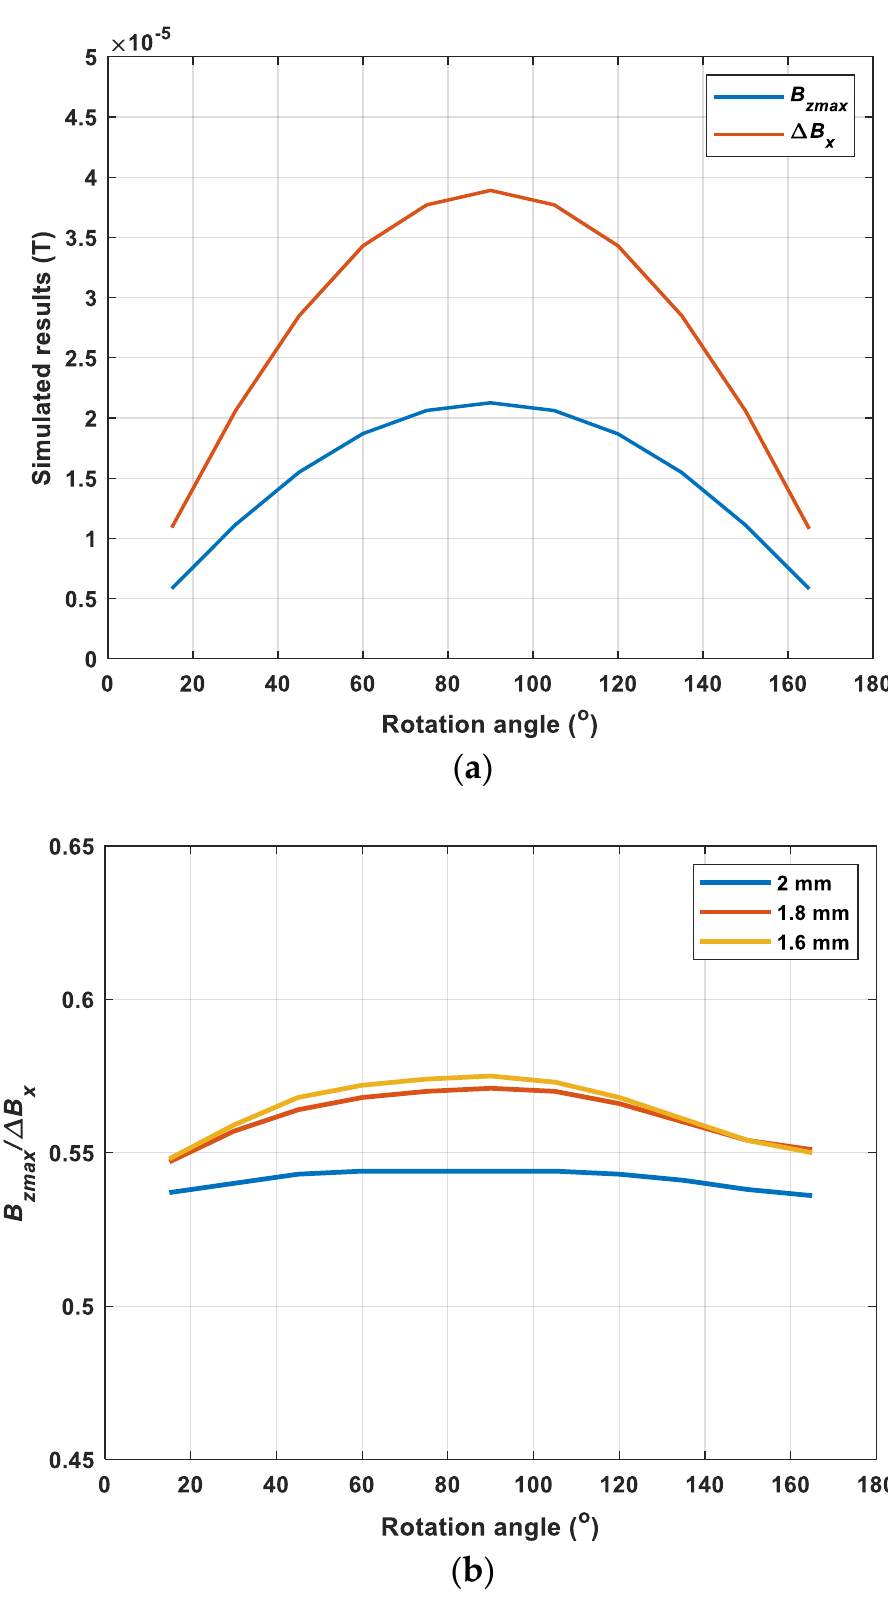
Figure 5. ( a ) The simulated results of the magnetic B field for the crack depth of 2 mm. ( b ) The ratio of the maximum of the z component and the change of the x component under varying rotation angles for different crack depths.